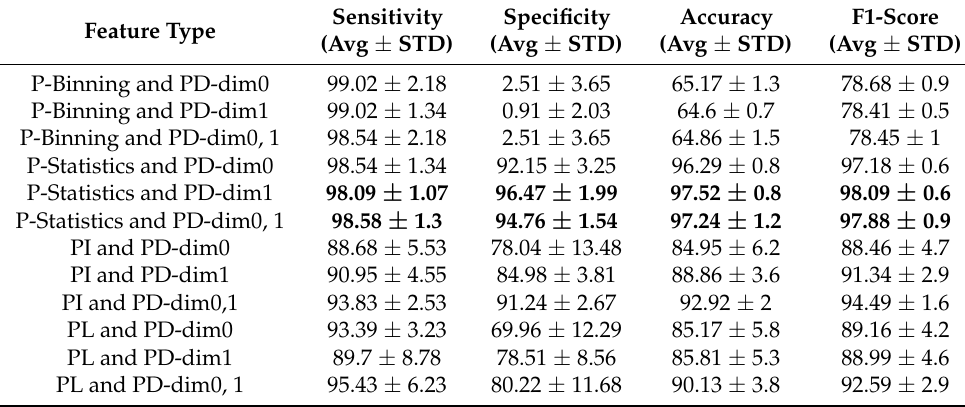
Table 4. Cubical complex performance results for the Mini-MIAS dataset using four different vector- ization methods and three homology